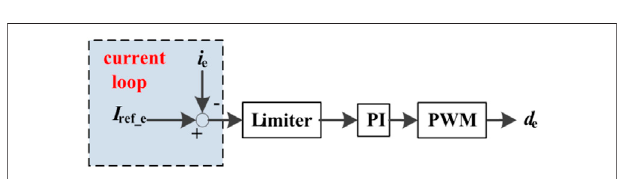
FIGURE 5 | The control structure diagram of High-Energy Battery.